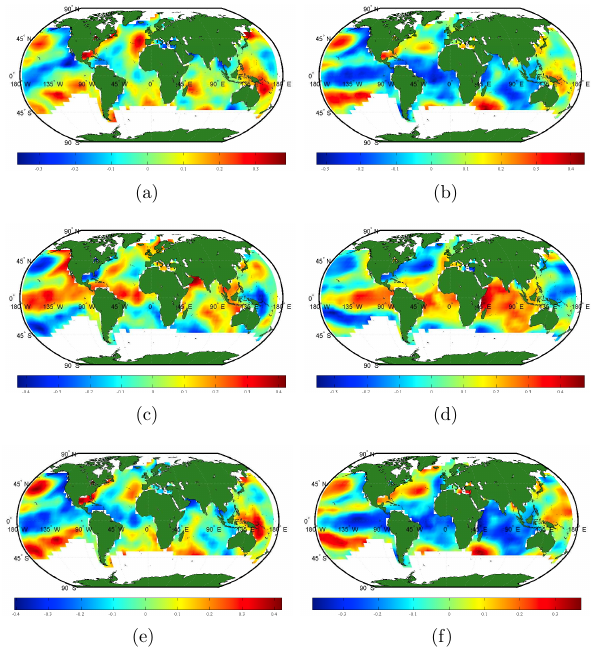
Fig. 5. Correlation maps between SSTa in the previous winter sea- son (DJF) and PCs. (a) China PC1 vs. SSTa; (b) China PC2 vs. SSTa; (c) India PC1 vs. SSTa; (d) India PC2 vs. SSTa; (e) Joint PC1 vs. SSTa; (f) Joint PC2 vs. SSTa.